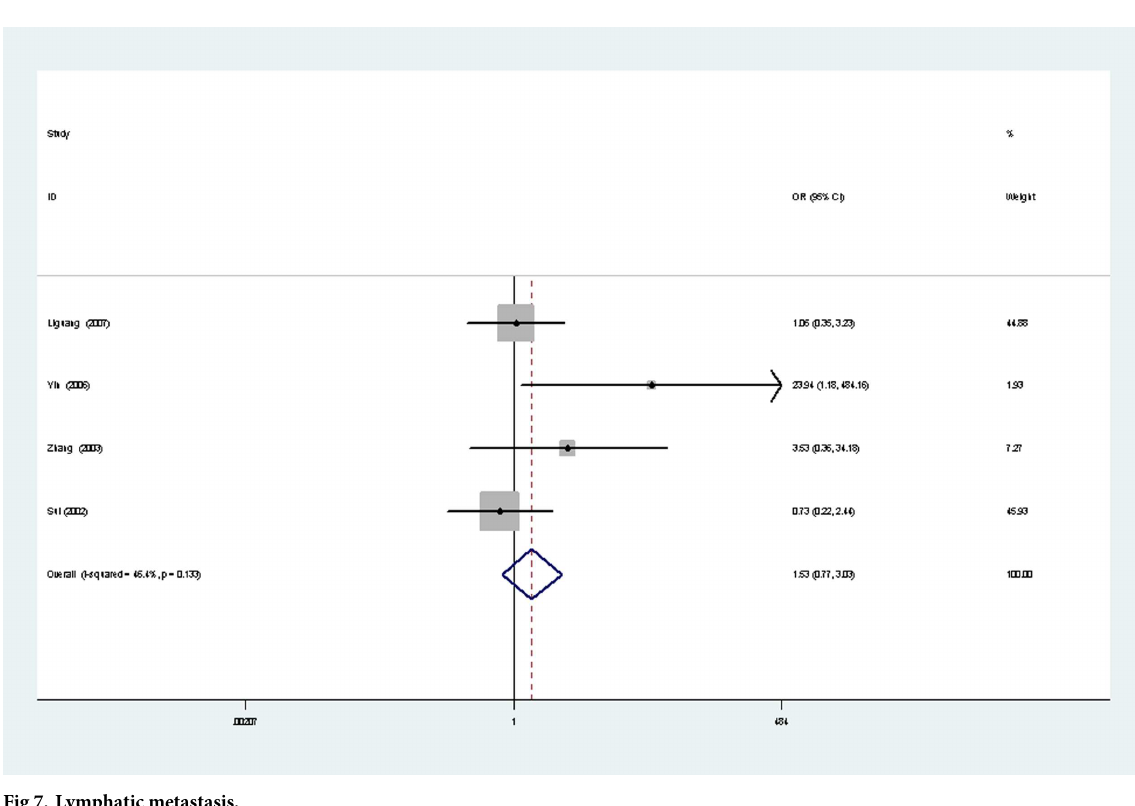
Fig 7. Lymphatic metastasis.